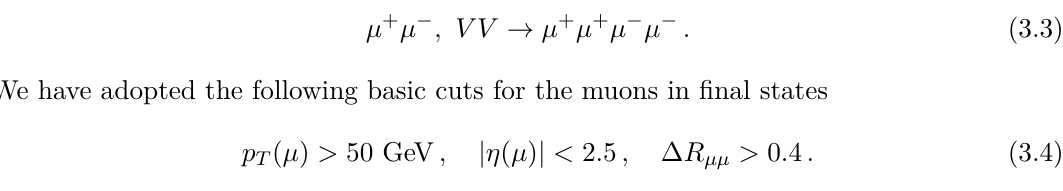
Figure 8 . Feynman diagrams of doubly and singly charged Higgs associated productions in Type II Seesaw. The diagrams are all produced by VBF processes (only V V → H ++ H − for illustration). into µ + µ − annihilation and VBF